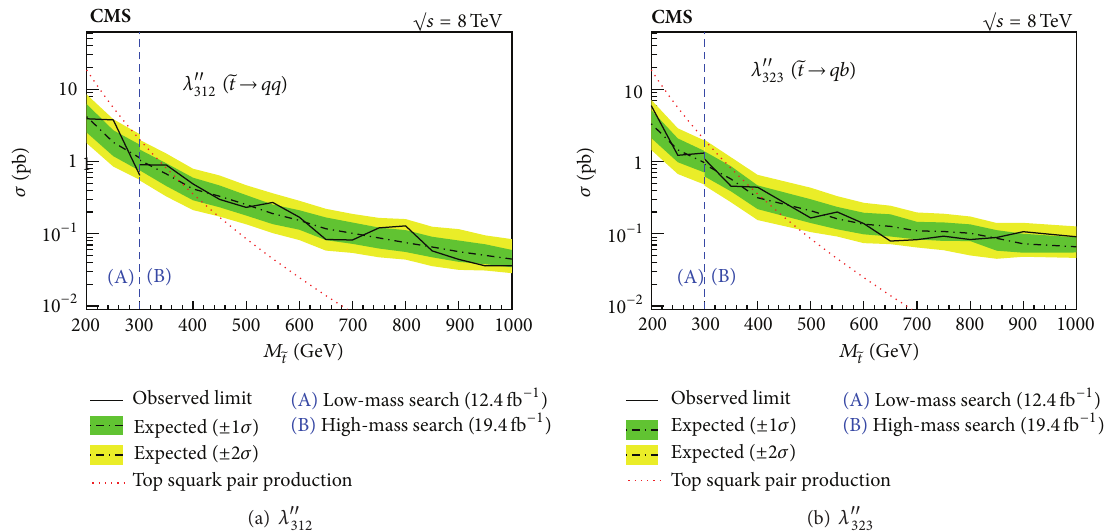
Figure 19: Observed and expected 95% CL cross section limits as a function of top squark mass for the inclusive (a) and heavy-flavor (b) searches for 𝑅 -parity-violating stop decays (from